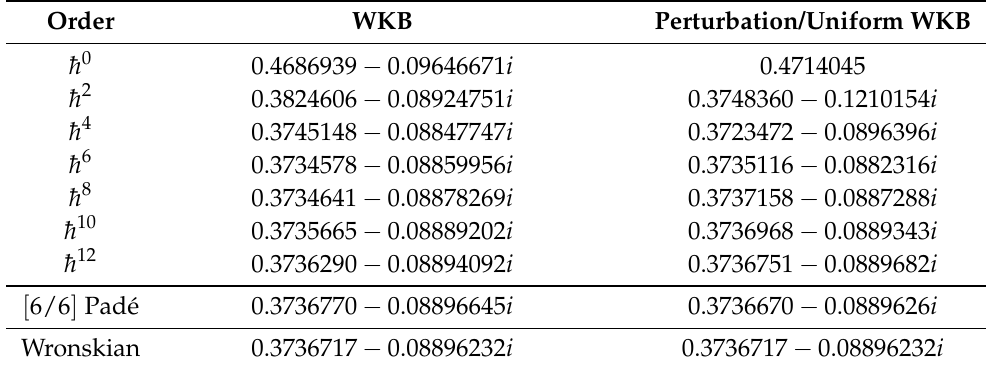
Table 1. The numerical fundamental QNM frequency for the gravitational perturbation s = 2 with (cid:96) = 2. The numerical values in the WKB analysis are determined by solving (152) for n = 0. The values in the perturbative analysis are obtained from (168). The same result as (168) is also obtained by the uniform WKB analysis. These approximate methods get better in the eikonal limit (cid:96) → ∞ , and thus (cid:96) = 2 is the most